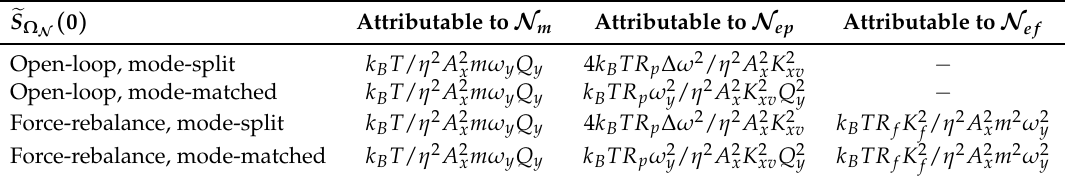
( 0 ) between different operations of vibratory gyroscopes. N